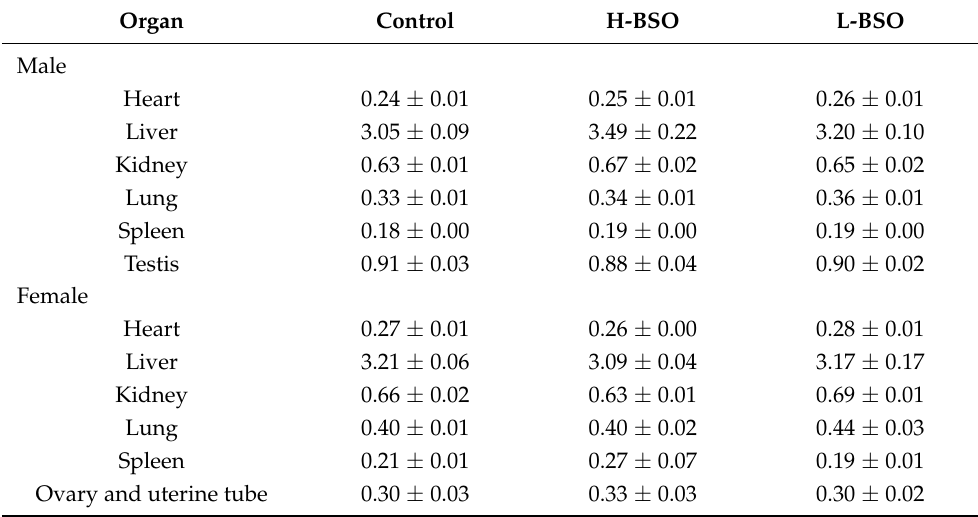
Table 6. Relative organ weight of the rats treated with BSO for 28